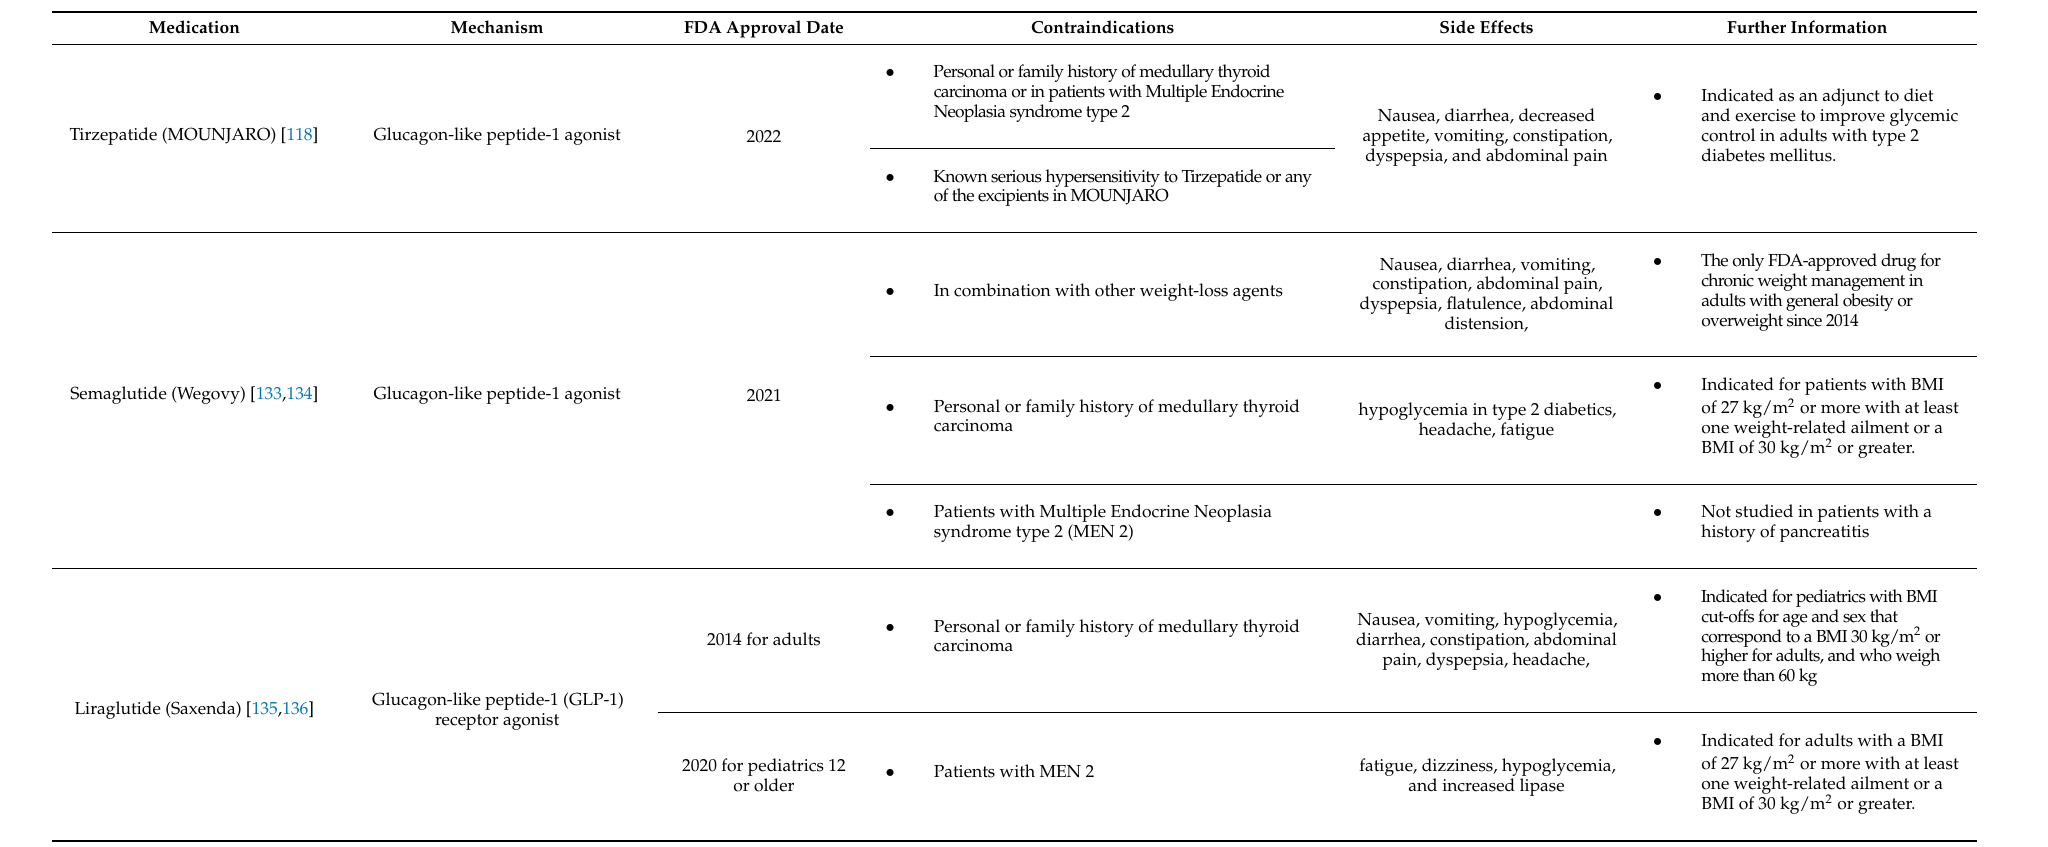
Table 1. FDA Approved medications for weight